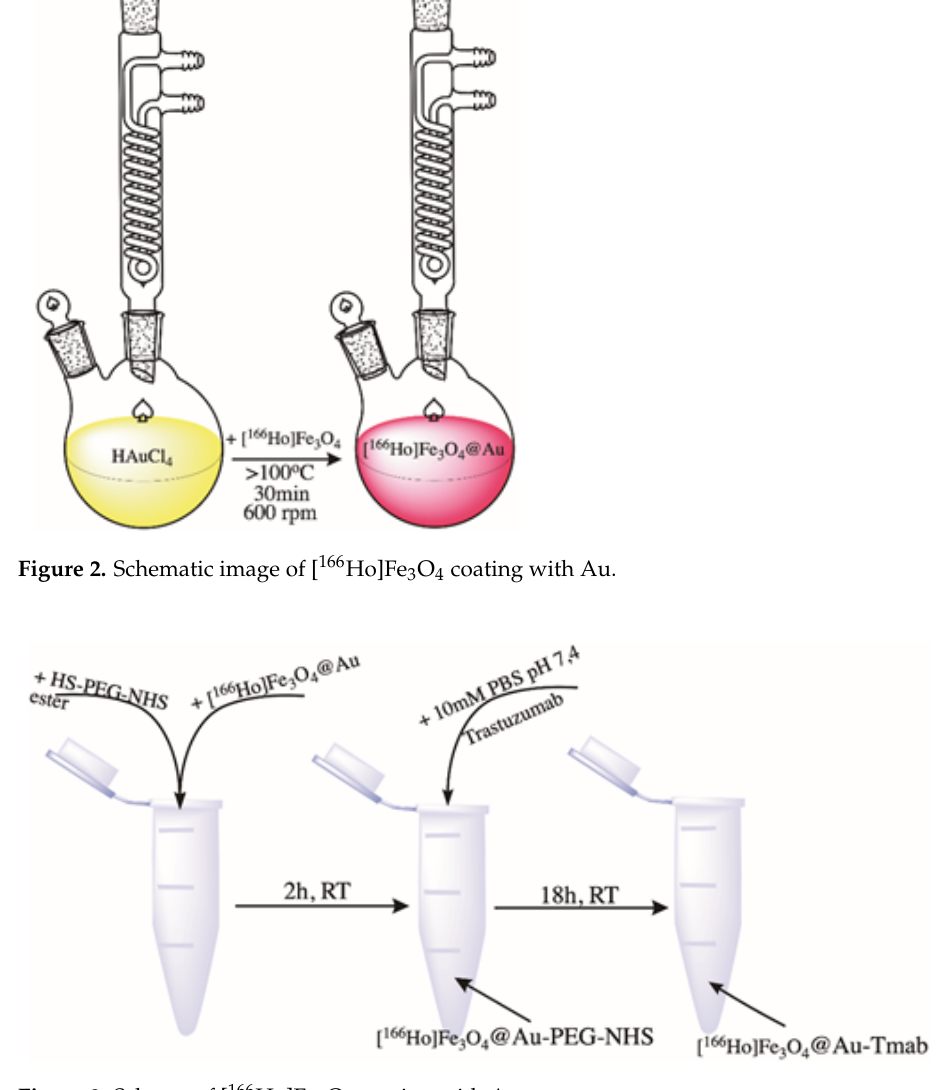
Figure 2. Schematic image of [ 166 Ho]Fe 3 O 4 coating with Au.